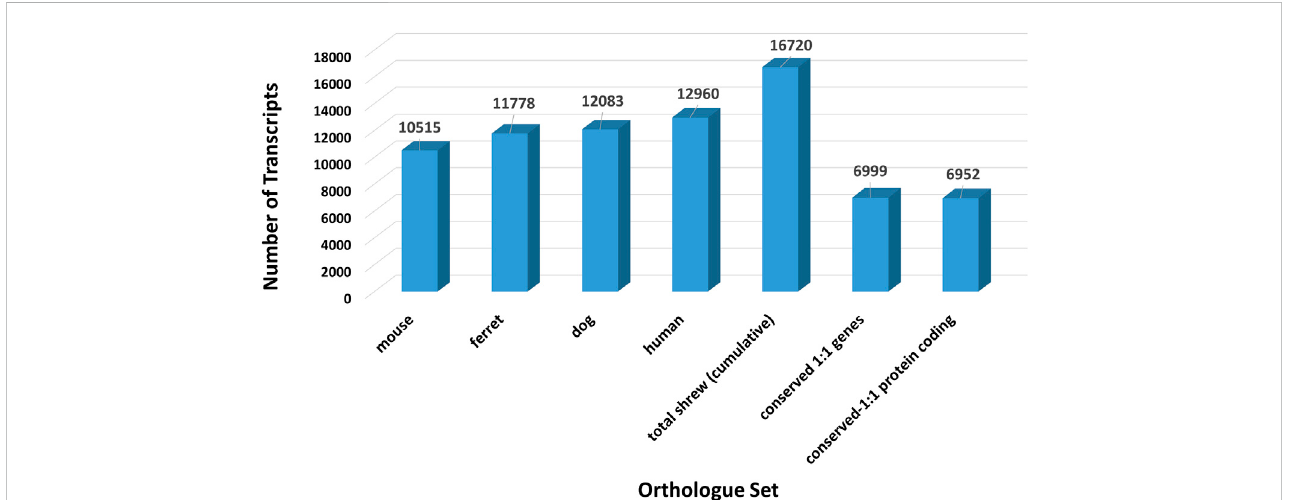
FIGURE 3 Number of orthologous transcript sequences across species and shared among species. Total number of identi fi ed ortholgous sequences between the initial setof transcript fasta sequences assembledfrom the shrew ( Cryptotis parva )brain stem and gut RNA sequencing reads and nucleotide sequences from dog ( Canis familiaris ), ferret ( Mustela putorius furo ), mouse ( Mus musculus ), and human ( Homo sapiens ). The complete set of orthologous transcript sequences identi fi ed in shrew by assembling transcripts across dog, ferret, mouseand human (illustrated in Figure 2) is shown for comparison purposes. Conserved genes and protein coding genes across all fi ve species (shrew, dog, ferret, mouse,